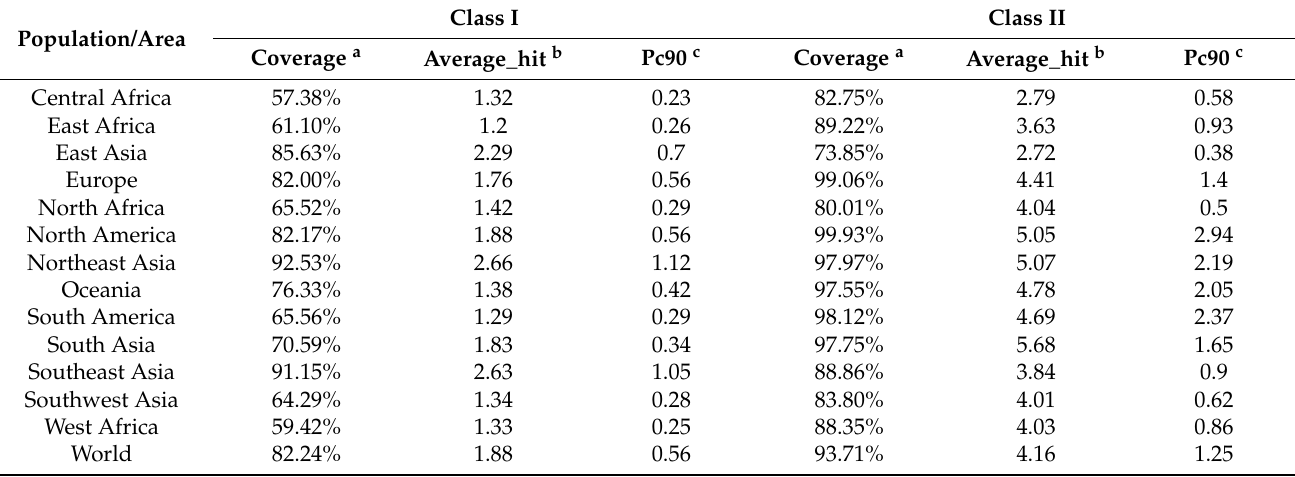
Table 2. Global population coverage of the PP19128R vaccine for HLA I and II